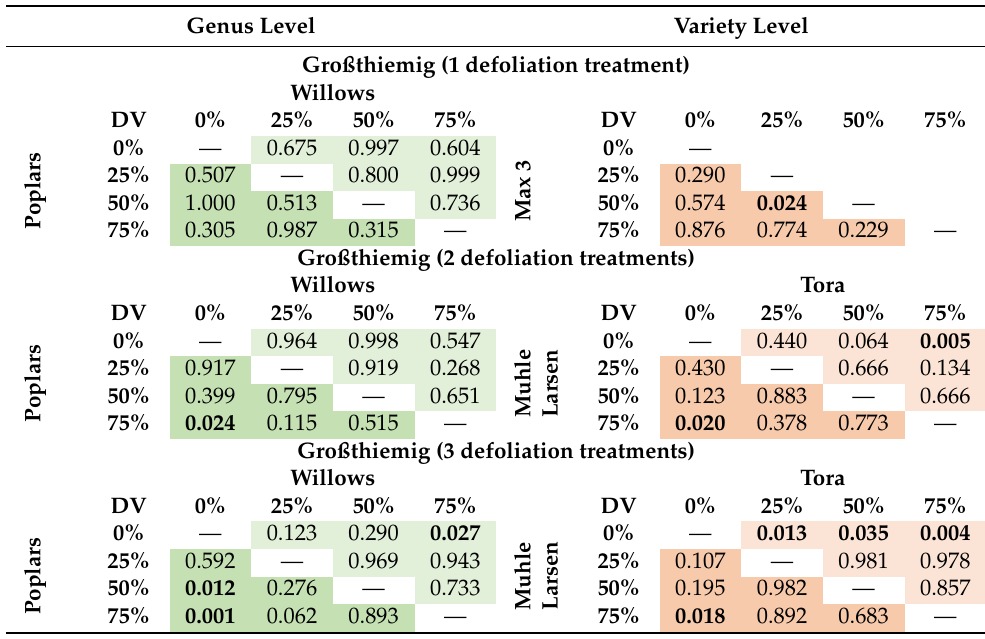
Table 2. p values of pairwise comparisons of plant heights among defoliation variants (DVs) for both tree genera (green) as well as for all varieties with at least one significant value (orange) on the study site in Großthiemig with regard to the number of defoliation treatments prior to the start of the growing season in 2009 via Tukey HSD test (bold values indicate statistically significant